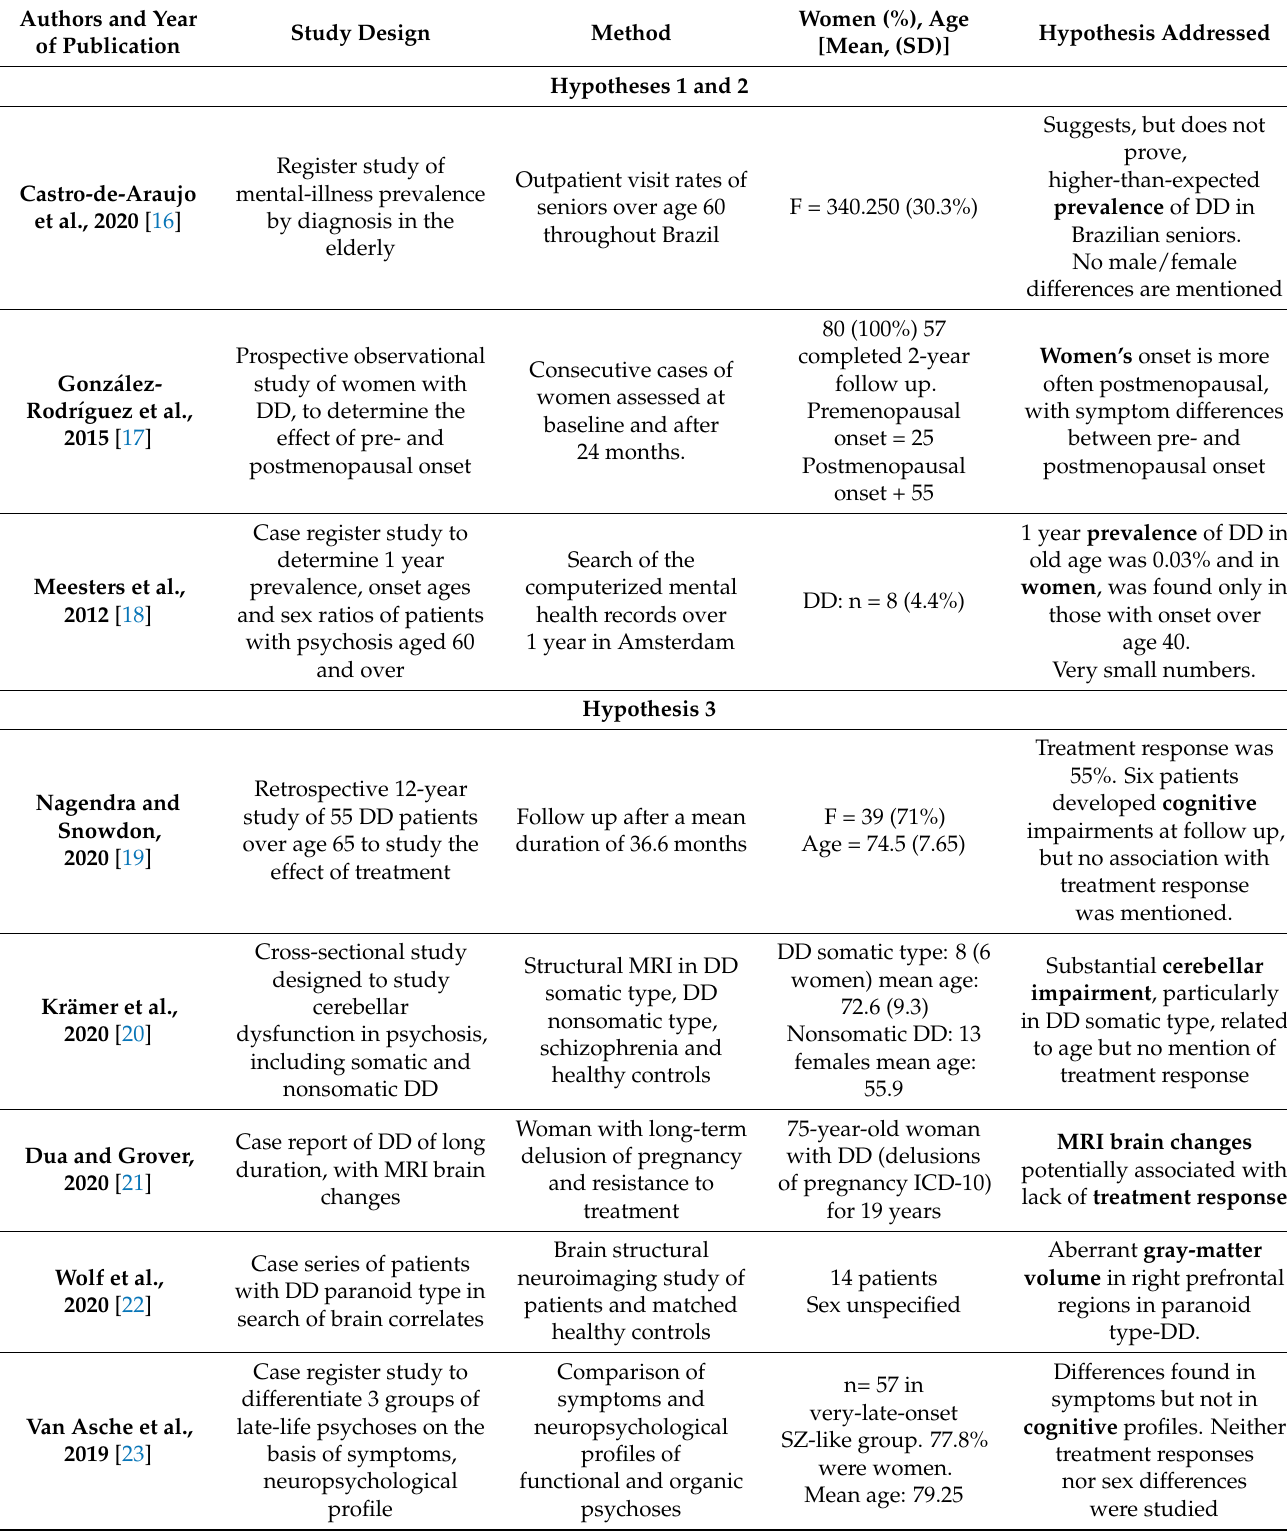
Table 1. Main characteristics of studies addressing epidemiology, risk factors, clinical features and treatment outcomes in elderly DD patients (n =